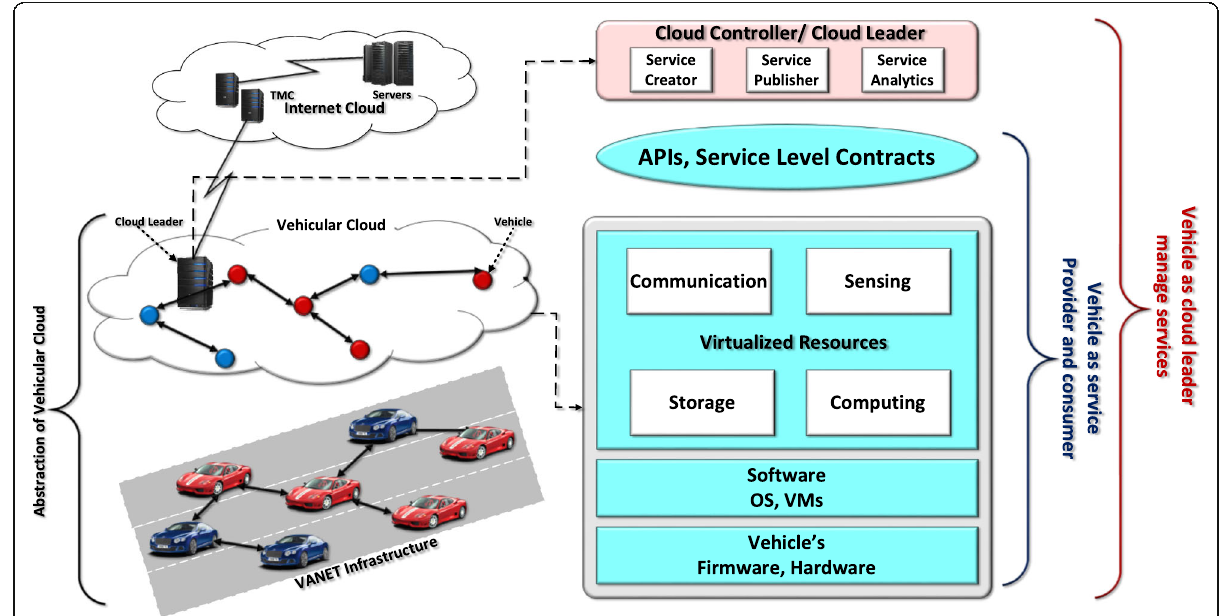
Fig. 5 The vehicular cloud computing for exploiting the proposed